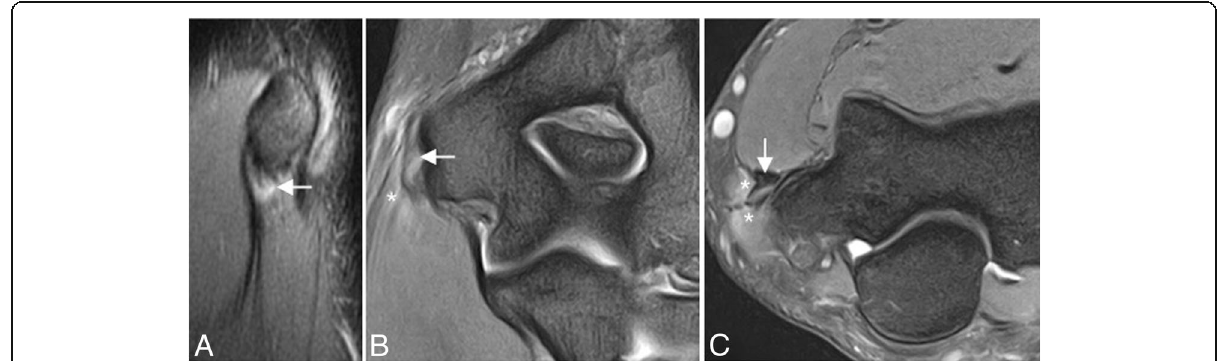
Fig. 10 A 45-year-old man with medial elbow pain. Sagittal PD-weighted MRI ( a ), coronal FS PD-weighted MRI ( b ), and axial FS PD-weighted MRI ( c ) showing a common flexor tendinosis with intermediate signal within a diffusely thickened flexor tendon origin (white arrows). Note flexor digitorum superficialis and palmaris longus muscle edema (white asterisks)